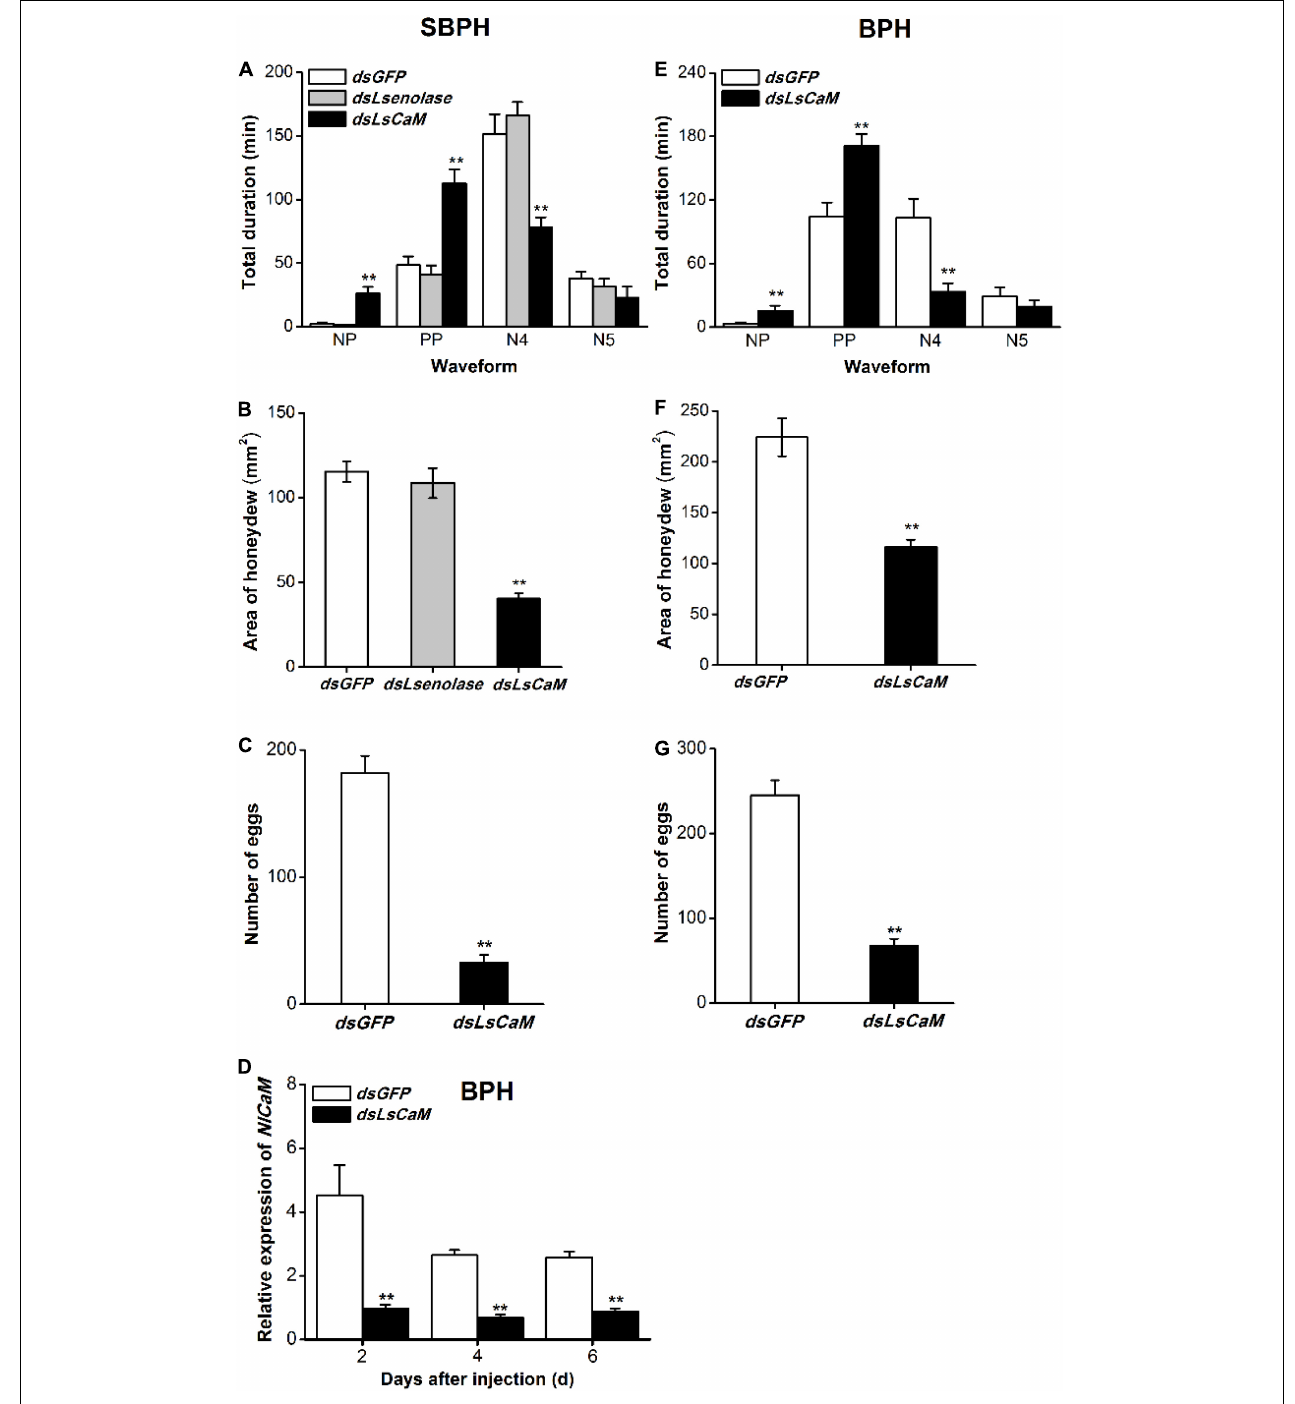
FIGURE 2 | Calmodulin knockdown reduced feeding and fecundity of SBPH and BPH. (A,E) Mean duration + SE ( n = 15) at different feeding phases of newly emerged SBPH (A) or BPH (E) female adults. Fifth-instar nymphs were injected with either indicated dsRNA 2 days before the EPG test. EPG waveform: NP, non-penetration; PP, pathway phase including penetration initiation, salivation and stylet movement, and extracellular activity near the phloem; N4, phloem phase; N5, xylem phase. (B,F) Mean area + SE ( n = 15) of honeydew excretion on filter paper by newly emerged SBPH (B) or BPH (F) female adults receiving same foregoing treatments. Area of honeydew excretion corresponds to insect feeding intake. (C,G) Mean number of eggs + SE ( n = 15) laid by a female SBPH (C) or BPH (G) adult receiving same foregoing treatments. (D) Mean NlCaM transcript levels + SE ( n = 3) in BPH 2, 4, and 6 days after dsLsCaM or dsGFP injection. Asterisks indicate significant changes in feeding behavior (A,E) , honeydew excretion (B,F) , fecundity (C,G) , and gene expression (D) of planthoppers injected with dsLsCaM or dsLsenolase compared to those injected with dsGFP (** P < 0.01; Student’s t -tests).